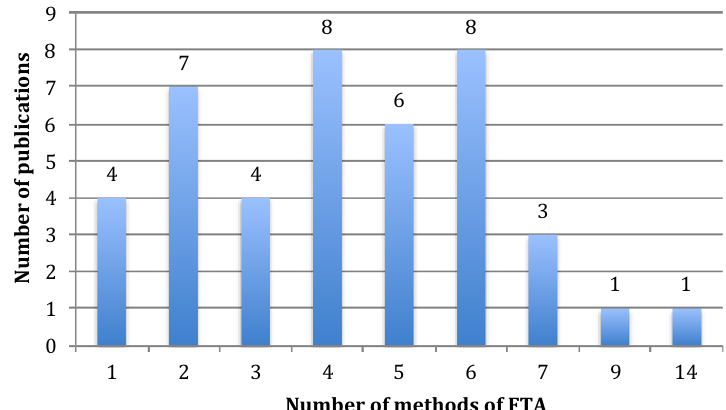
Fig. 4 Number of methods of FTA used in e-Government